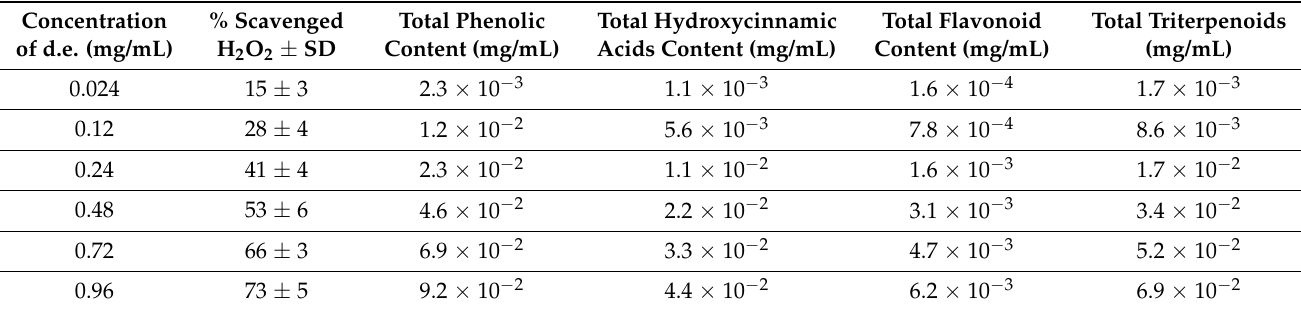
Table 3. Total phenolic content and percentage of scavenged hydrogen peroxide as a function of increasing concentrations of Ro ex.